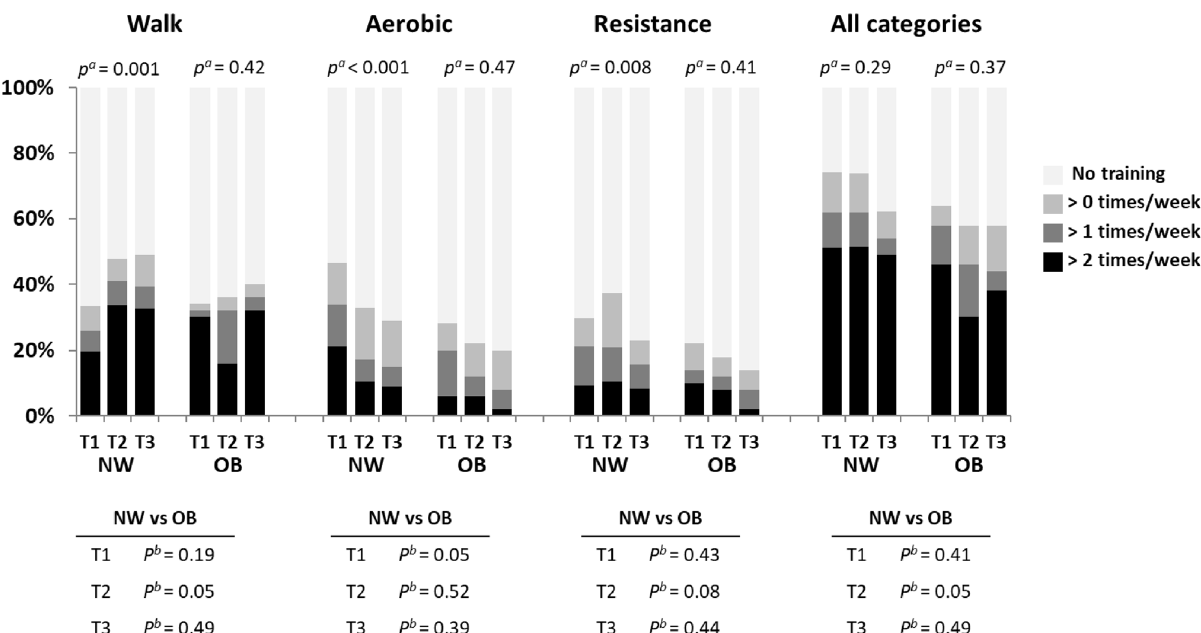
Figure 2. The number of training sessions per week during pregnancy in women of normal-weight or with obesity. The self-reported exercise was categorized into “walk”, aerobic” or “resistance” type training. a Significance using Friedmans test over trimesters 1–3. b Significance between NW and OB using Chi 2 tests. NW, women of normal-weight; OB, women with obesity; T1, trimester 1; T2, trimester 2; T3, trimester